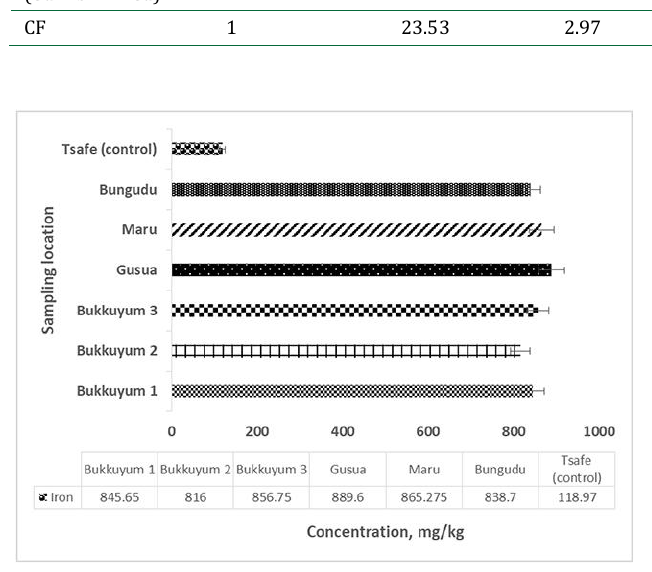
Figure 6: Iron levels in contaminated soils in comparison with the